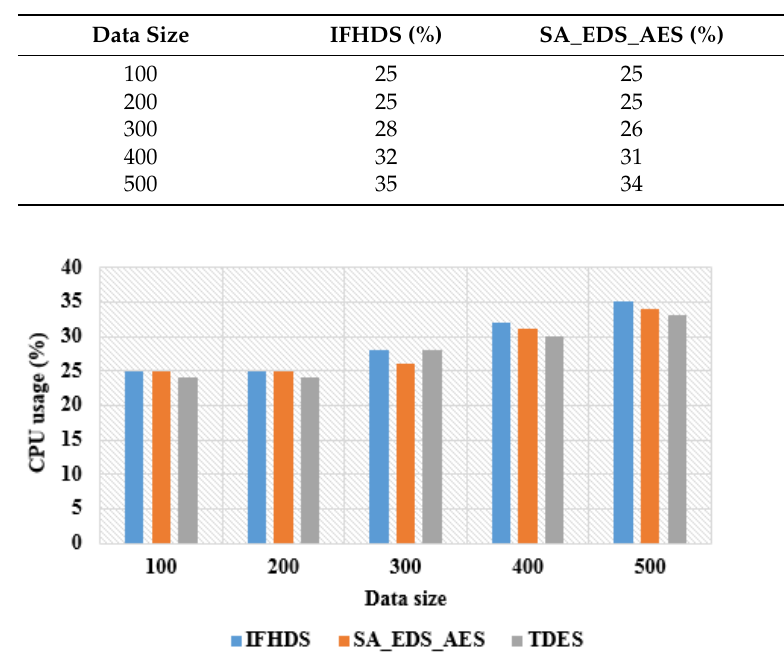
Figure 6. TDES CPU usage comparison with existing techniques.